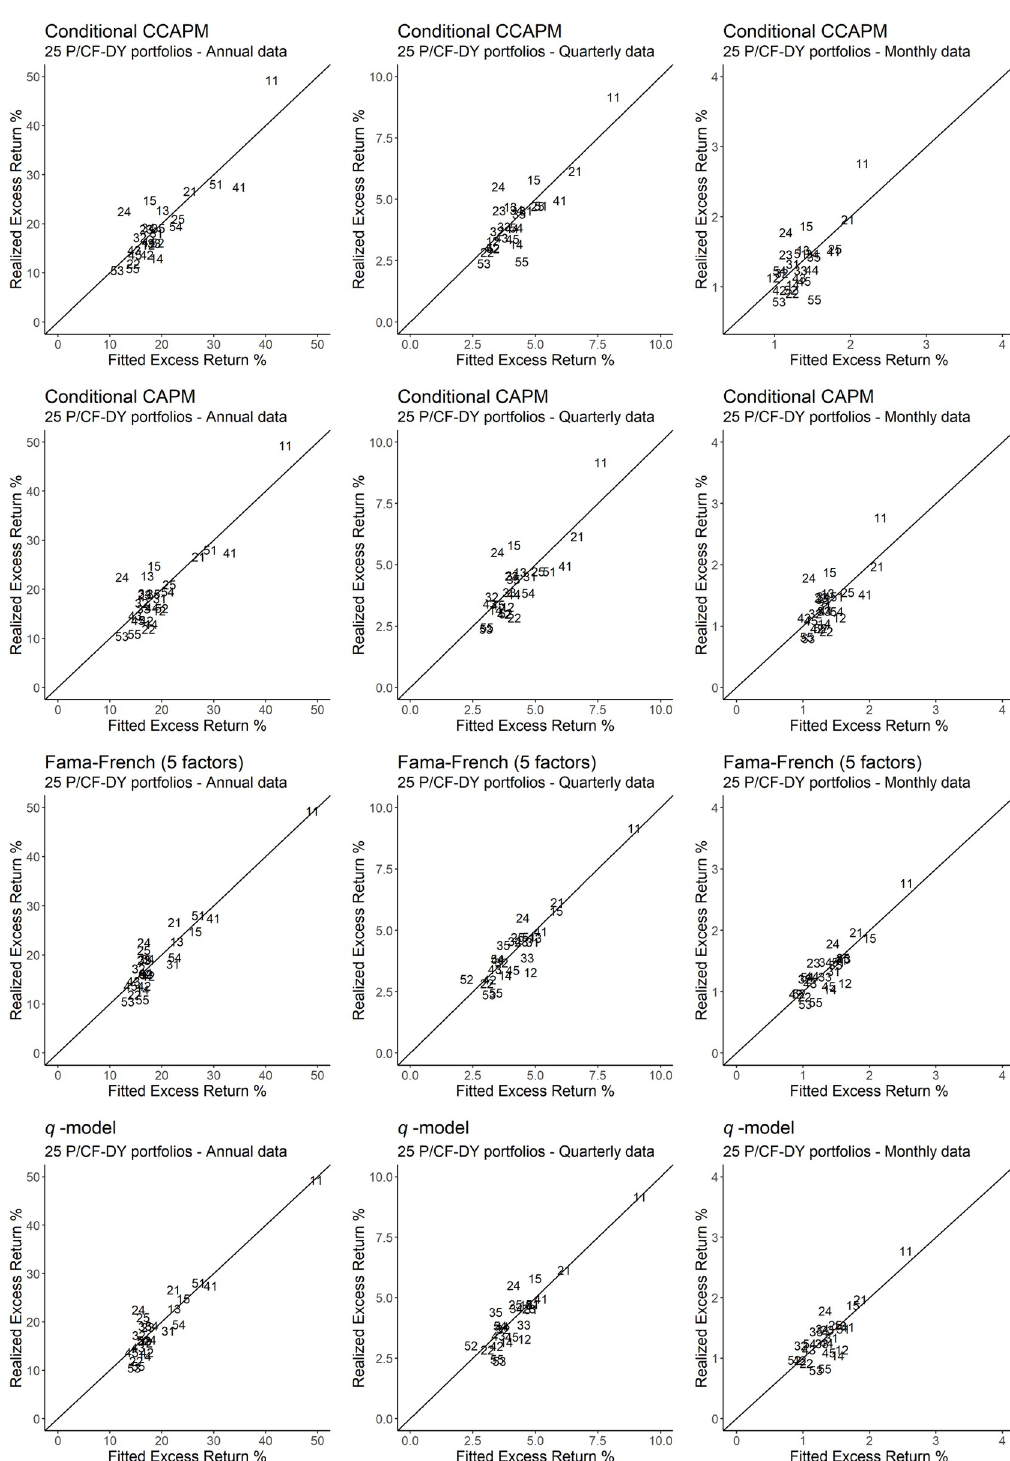
Fig 3. Realized excess returns versus fitted values for 25 portfolios P/CF-DY. The figure depicts 25 portfolios P/CF-DY using a code with two numbers, the first number being the P/CF ratio code (with 1 representing a low ratio and 5 a high ratio) and the second number being the DY code (with 1 representing a low ratio and 5 a high ratio). The closer the portfolios are to the 45 degrees axis, the better the fit produced by the model.